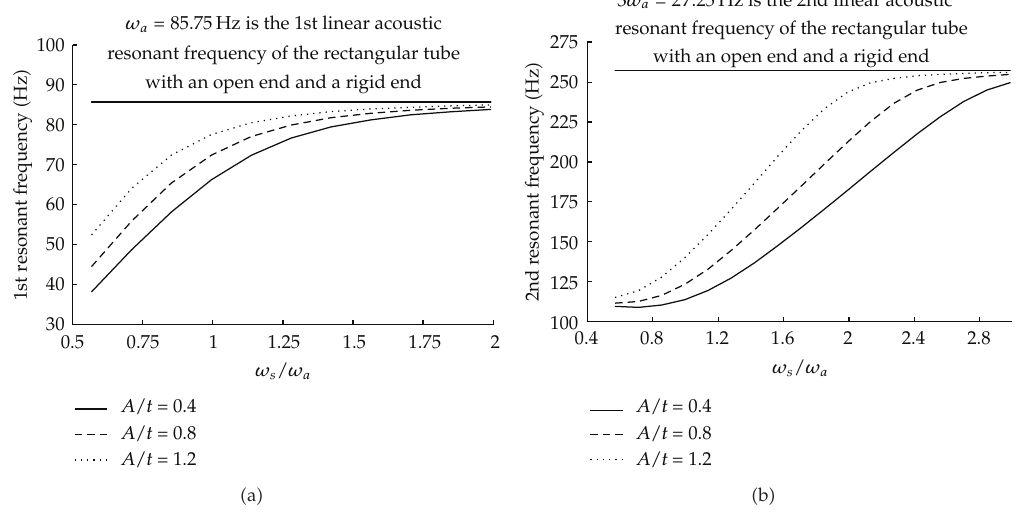
Figure 4: (cid:3) a (cid:6) The 1st nonlinear resonant frequency versus ω s /ω a (cid:3) A/t (cid:7) 0 . 4, 0.8, 1.2mm (cid:6) . (cid:3) b (cid:6) The 2nd nonlinear resonant frequency versus ω s /ω a (cid:3) A/t (cid:7) 0 . 4, 0.8, 1.2mm (cid:6) .